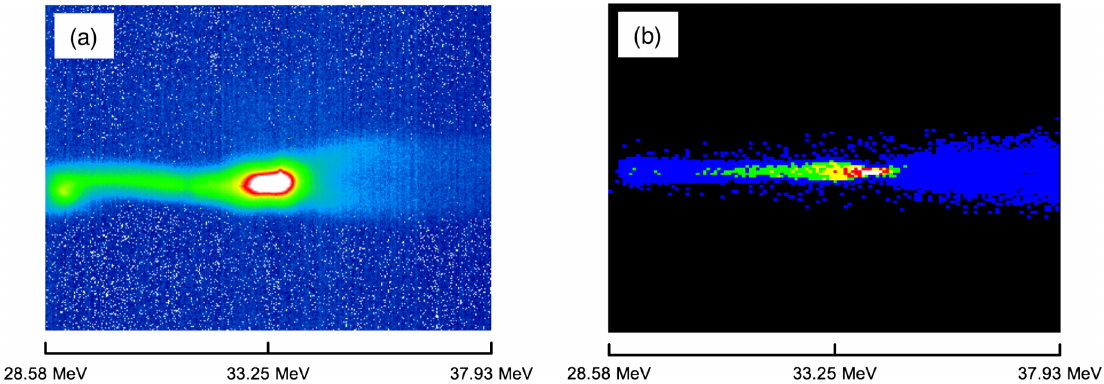
FIG. 9. Energy profiles at energy dispersive part of BC1. (a) Measured and (b) simulated (by PARMELA code) energy profiles at the injector